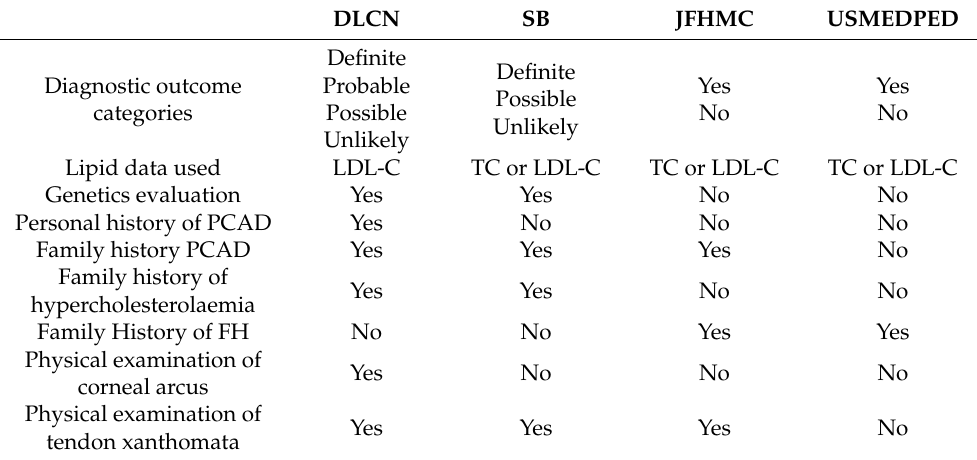
Table 3. Summary of all FH diagnostic criteria tools and their related variables used in MyHEBAT- FH